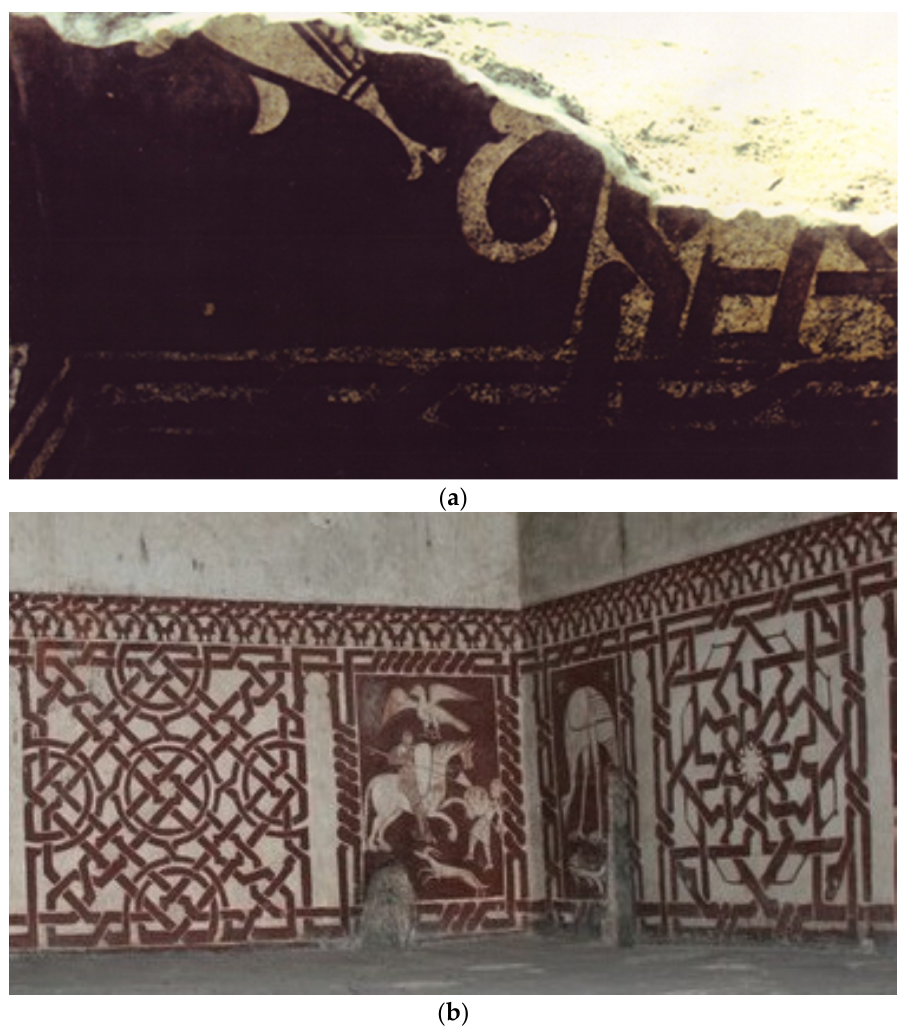
Figure 10. Style of “bichrome backgrounds”. Animal themes as the main elements on red back- grounds: ( a ) Fish on a plinth of the Palacio de Orive, 12th century (Murillo et al. 1992); ( b ) Christian plinths in the Tower of Hercules, Segovia, 13th century (Villanueva et al. 2023).